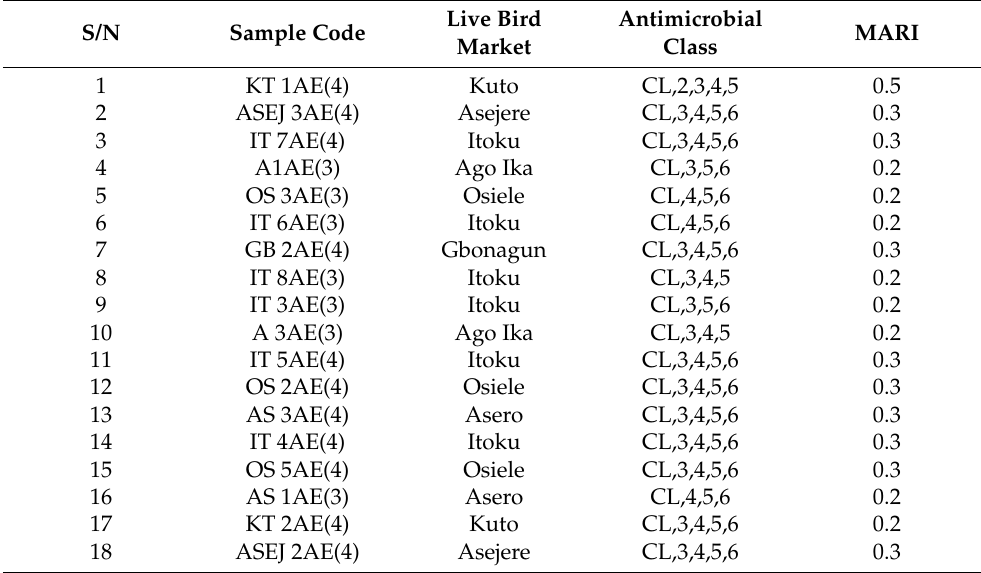
Table 5. Multiple antimicrobial resistance indices (MARI) of antimicrobials used in live bird markets Abeokuta Ogun